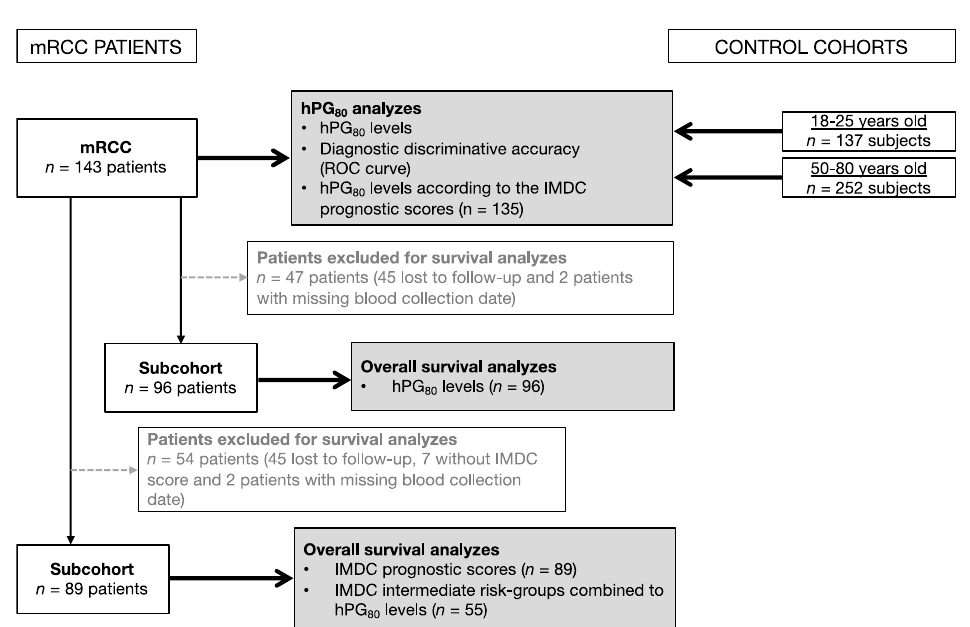
Figure 1. Flowchart of the study with mRCC patients.